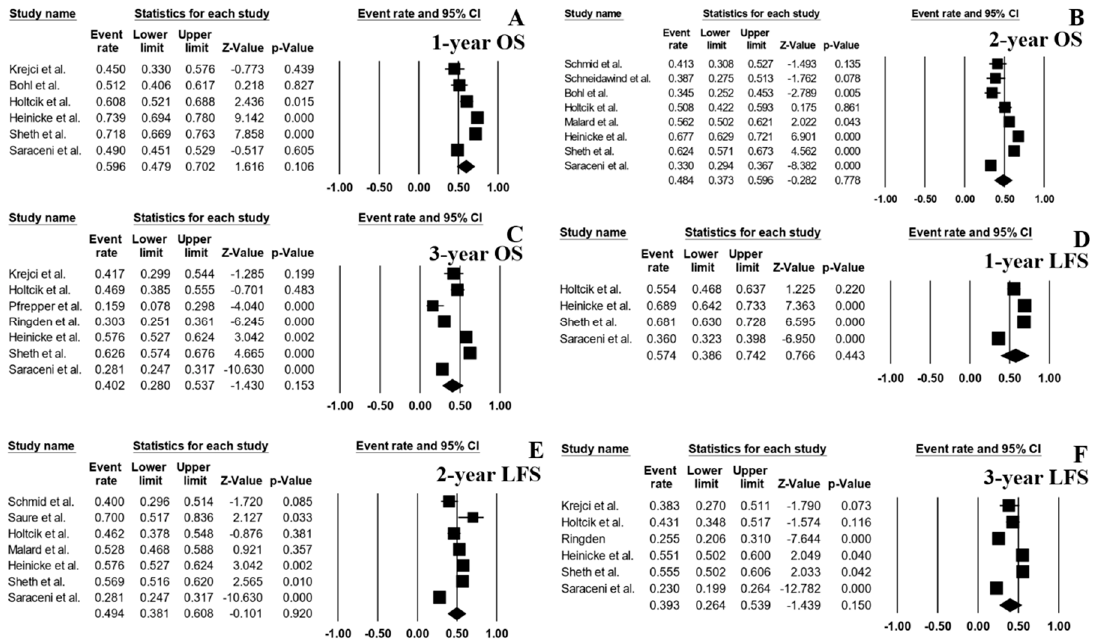
Figure 2. Forest plots of pooled estimates (95% confidence interval (CI)) for overall survival (OS) and leukemia-free survival (LFS) after hematopoietic stem cell transplantation (HSCT); ( A ): 1-year OS; ( B ): 2-year OS; ( C ): 3-year OS; ( D ): 1-year LFS; ( E ): 2-year LFS; ( F ): 3-year LFS.